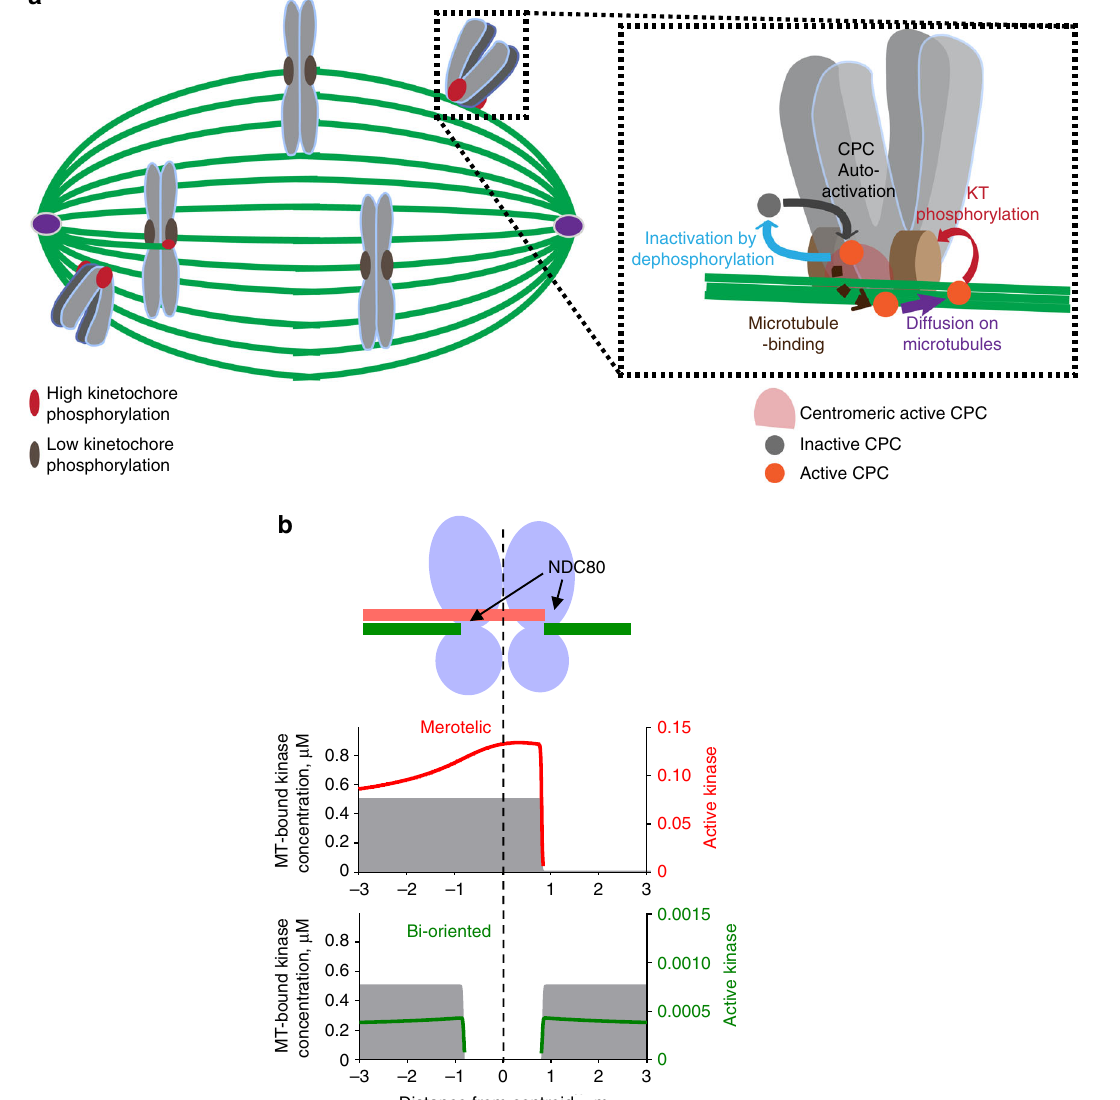
Fig. 9 Model for kinetochore phosphorylation by the CPC. a Model showing phosphorylation of laterally attached kinetochore by the CPC. Inactive non- centromeric pool of CPC (gray) is auto-activated by centromeric pool (red). The non-centromeric activated CPC (orange) diffuses on centromere proximal microtubules (green) and phosphorylates kinetochores (brown). b Theoretical results showing predictions obtained using our model for the activity of microtubule-bound kinase at the kinetochores with merotelic microtubules (cartoon illustration on top). Graphs show concentration of the microtubule- bound kinase for merotelic and end-on microtubules (in gray, left axis). Fraction of the active microtubule-bound kinase for merotelic (red curve) and end- on microtubules (green curve) is plotted using the right axes. Kinase activity on the end-on attached microtubules is more than 100-times lower than on the merotelic ones, even though they are bound at the same